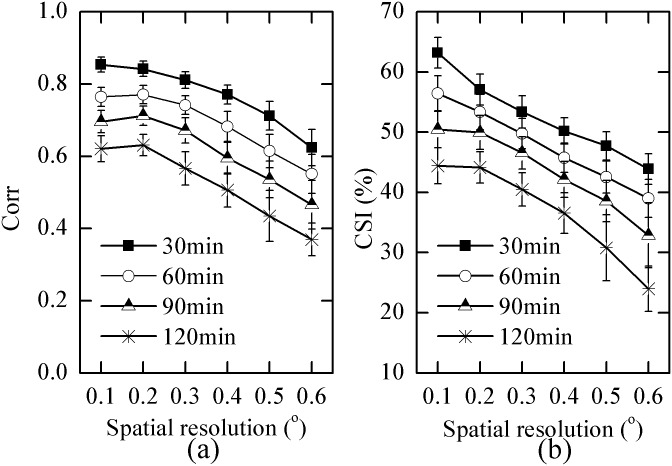
Average Corr and CSI of all 8 events for 0–120 min predictions vs. different spatial resolutions of FY-2F using PPLK.